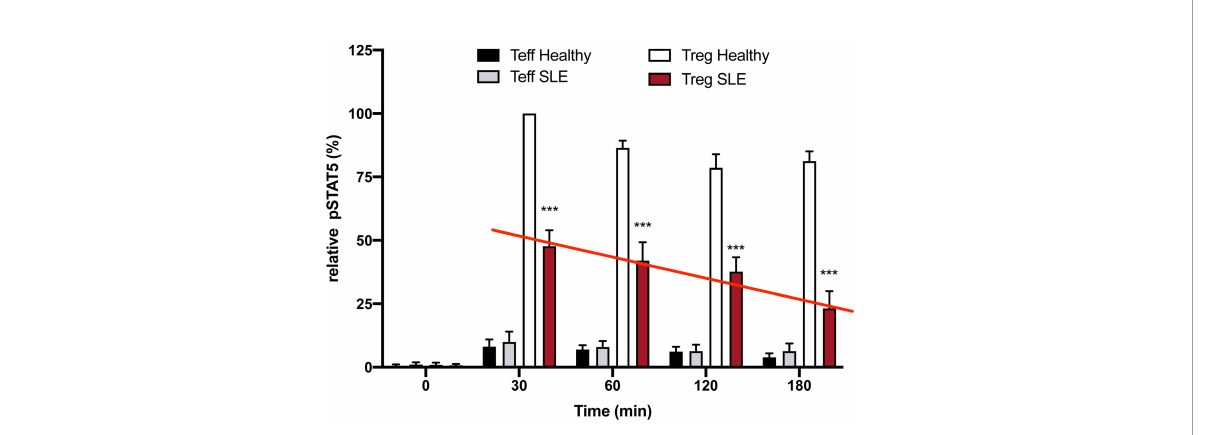
FIGURE 2 Defective inhibition of IL-2 desensitization in the T regs of SLE patients. The 25 SLE patients studied were selected from a clinic in Mexico City irrespective of current disease status. These graphs represent Western blot data of pSTAT5 phosphorylation in T effs and T regs of the SLE patients and healthy sex and age-matched controls after stimulation with low dose IL-2 (1 ng/ml; 25 IU/ml) for the indicated amounts of time. Expression is shown as a percent of pSTAT5 measured from 30 min-stimulated control T regs . A defect in the inhibition of IL-2R desensitization is observed in the T regs of SLE patients (red line) n=6 per group ***p < 0.001 by 2-way